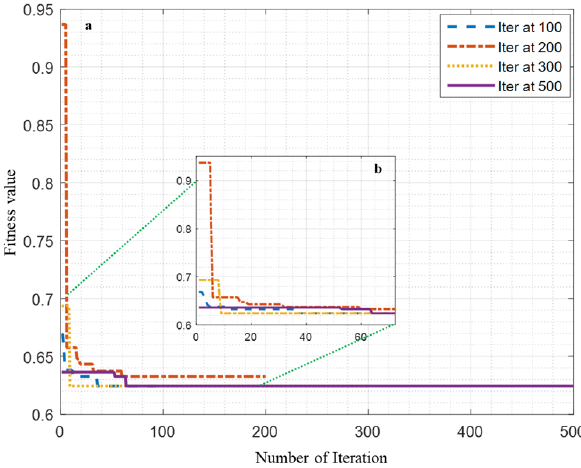
Figure 4. PSO performance for estimating lightning maps. ( a ) The PSO-convergence curves as a function of number of iterations and fitness value. ( b ) An expanded view of ( a ).